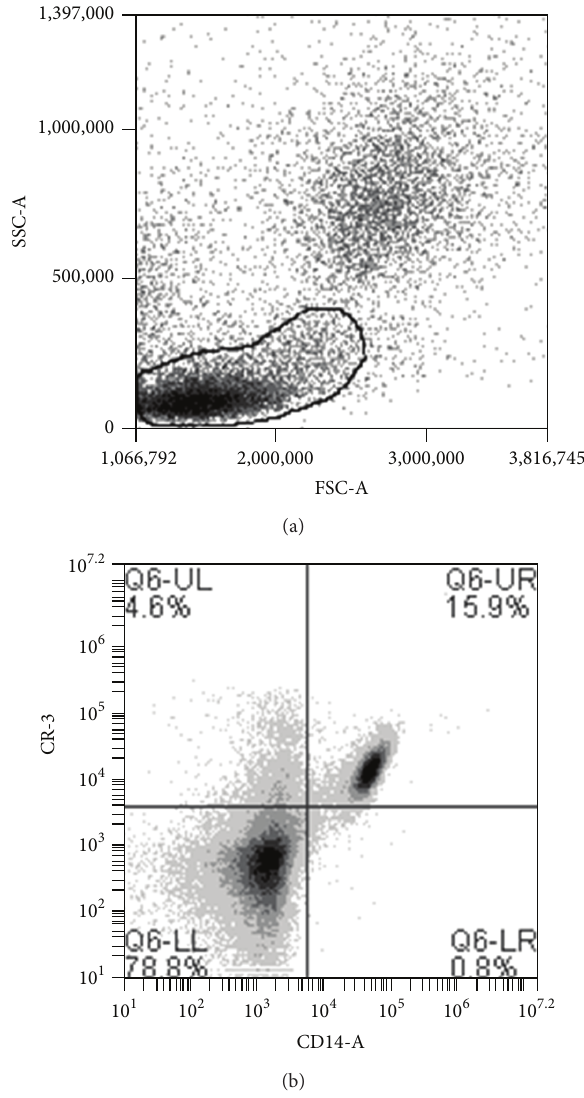
Figure 1: Gating procedures for CD14+ cells. (a) CD14+ cells selected from the specified region based on forward (FSC) and side scatter (SSC) properties. (b) Two-dimensional histogram displaying fluorescence characteristics of cells in selected region. Cells positive for CR3 and CD14 are displayed in the upper right